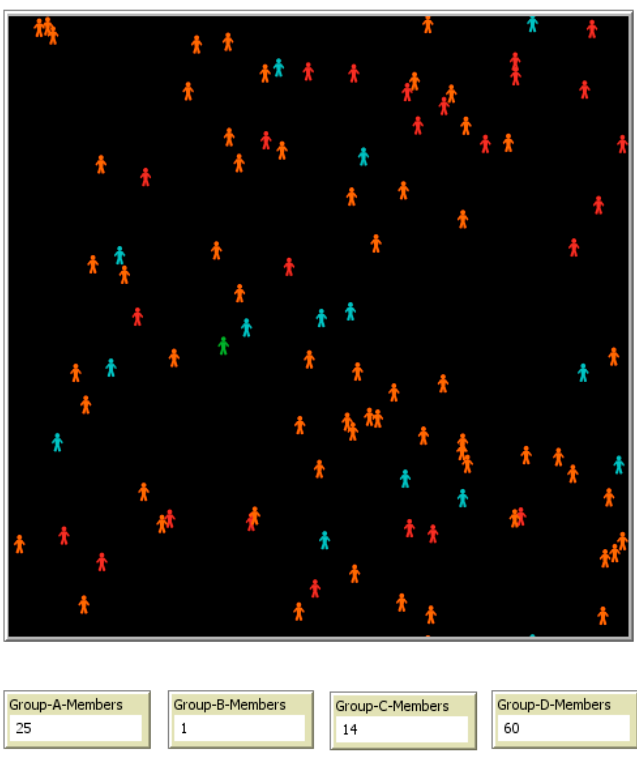
Figure 3. The types of agents created in NetLogo 6.0.4.